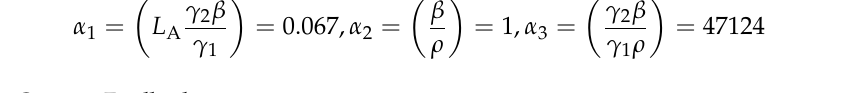
Table 1. Parameters of GaN class-D amplifier with fourth-order filter. Parameter Symbol